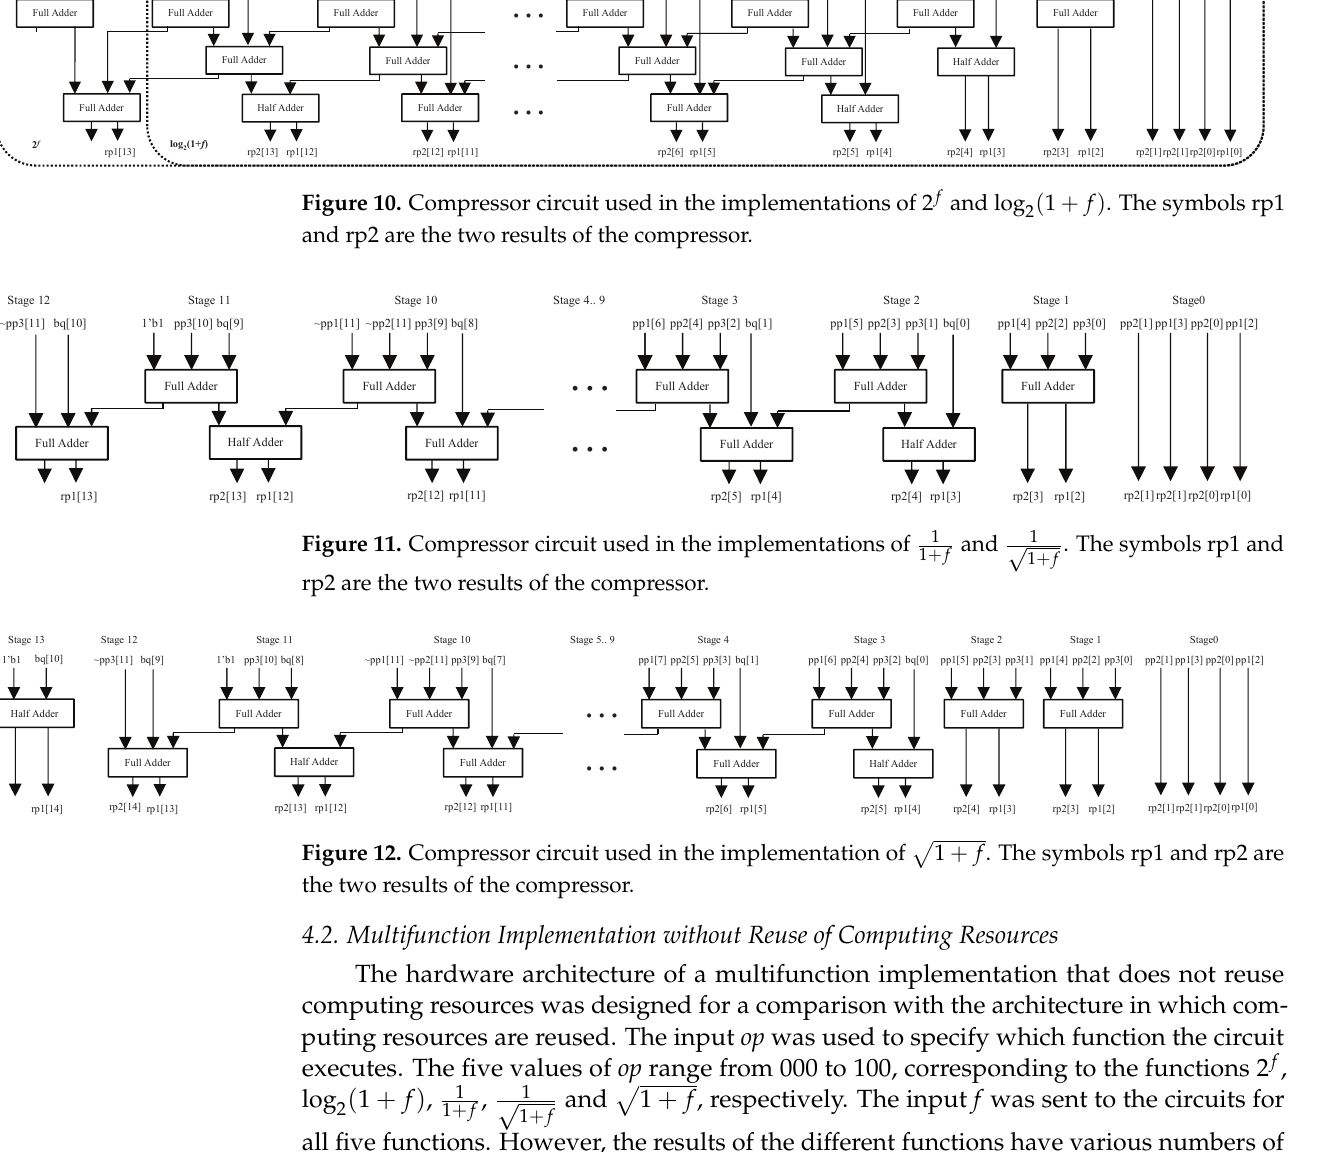
( 1 + f ) . The symbols rp1 2